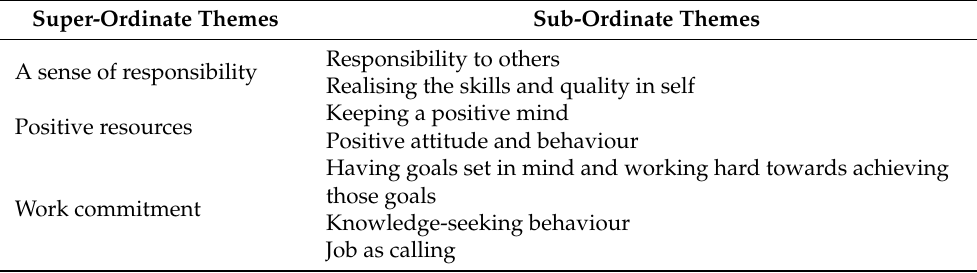
Table 3. Super-ordinate and sub-ordinate themes of ways participants experienced PsyCap. Super-Ordinate